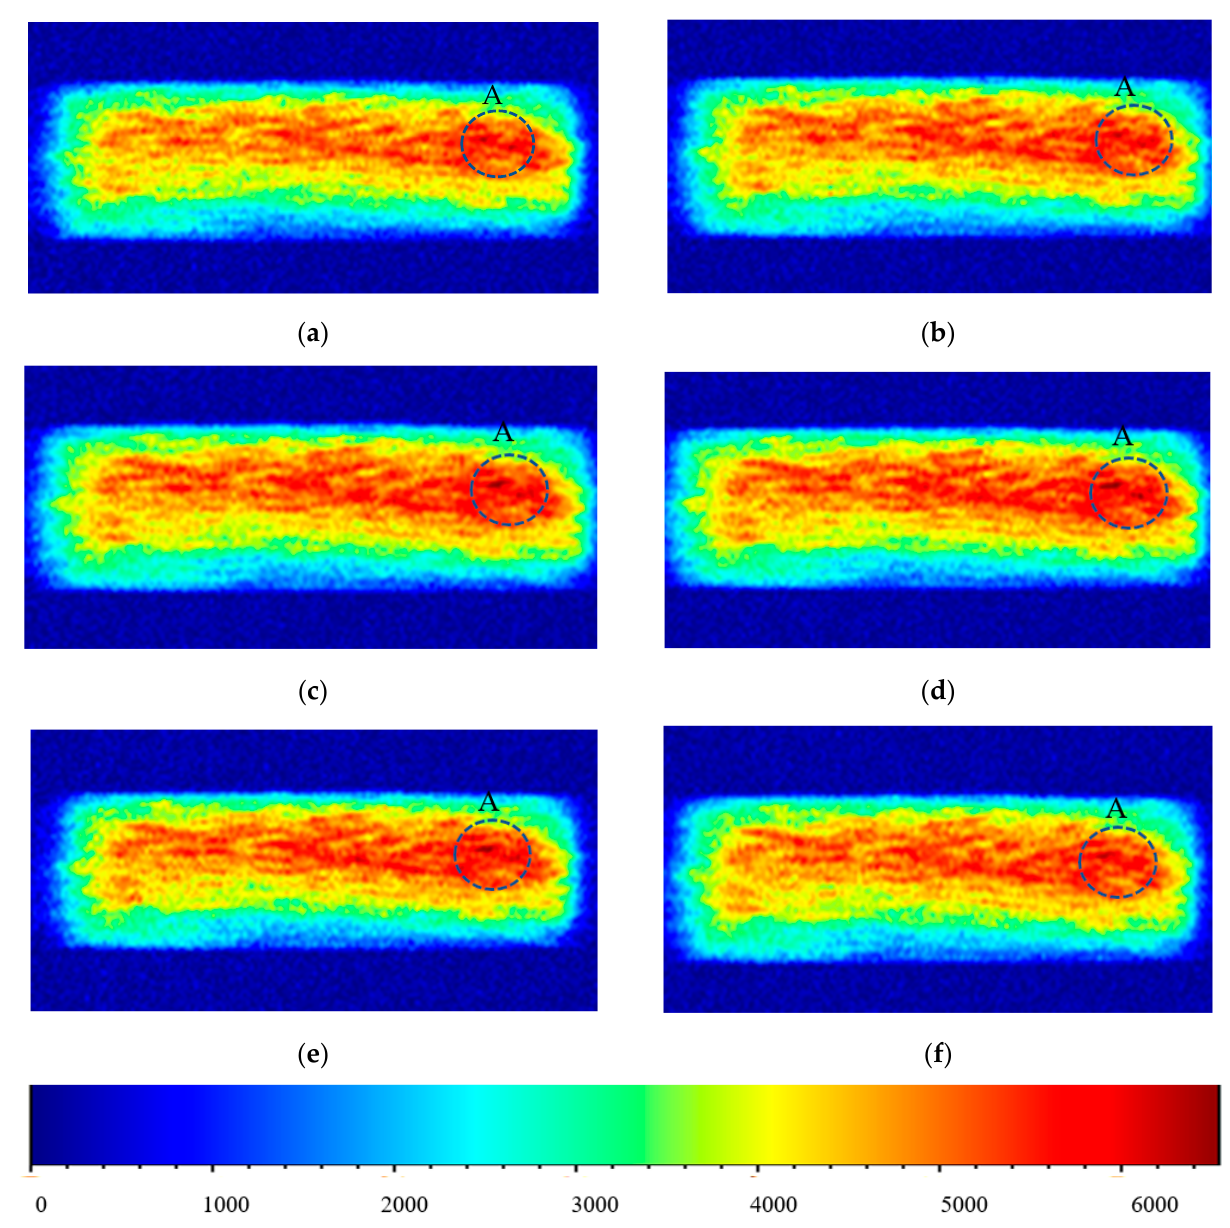
Figure 8. NMRI evolution of sandstone during the first cycle of fluid injection process (Note: large value of color code represents relatively large pore size, A domain in the circle shows the obvious variation). ( a ) P = 0 MPa. ( b ) P = 5 MPa. ( c ) P = 10 MPa. ( d ) P = 15 MPa. ( e ) P = 20 MPa. ( f ) P = 25 MPa.